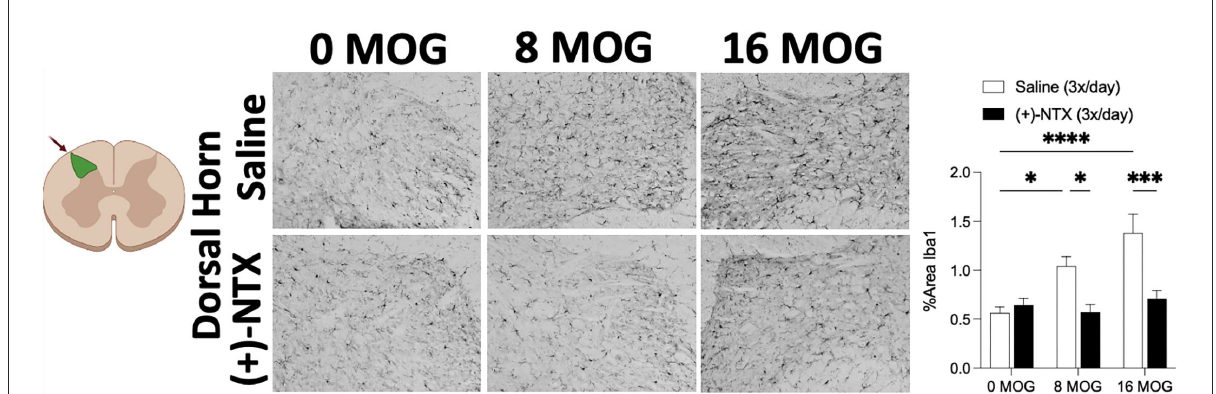
FIGURE7 Myelin oligodendrocyte glycoprotein (MOG) induces lumbar spinal cord dorsal horn Iba1 immunoreactivity that is reversed by daily systemic administration of the TLR2–TLR4 antagonist ( + )-Naltrexone [( + )-NTX]. Sprague-Dawley (SD) from Experiment 2 received intradermal low-dose (0, 8, and 16 µ g) myelin oligodendrocyte glycoprotein (MOG). Spinal cord tissue was collected on day 30 post-MOG administration and during 13 days of daily ( + )-NTX administration. Both doses of MOG increased expression of the microglial immunoreactivity marker Iba1 in dorsal horn of lumbar spinal cord, which was reversed to 0 µ g MOG control levels by ( + )-NTX administration. Main effects of MOG [ F (2, 86) = 9.66; p < 0.001], ( + )-NTX [ F (2, 86) = 19.57; p < 0.0001], and interaction between MOG and ( + )-NTX [ F (2, 86) = 7.81; p < 0.001]. N = 3–8/group, with 2–4 pictures analyzed per subject. Post-hocs : * indicates significant differences between groups (* p < 0.05, ** p < 0.01, *** p < 0.001, **** p <